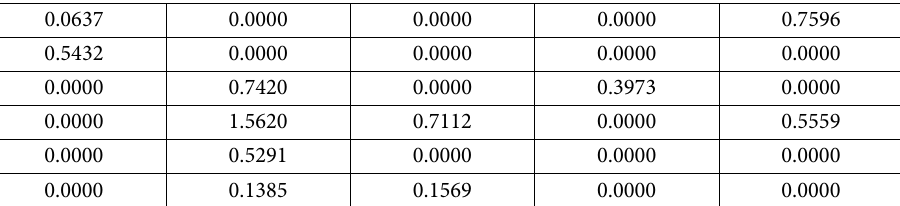
Table 10. The PDAS